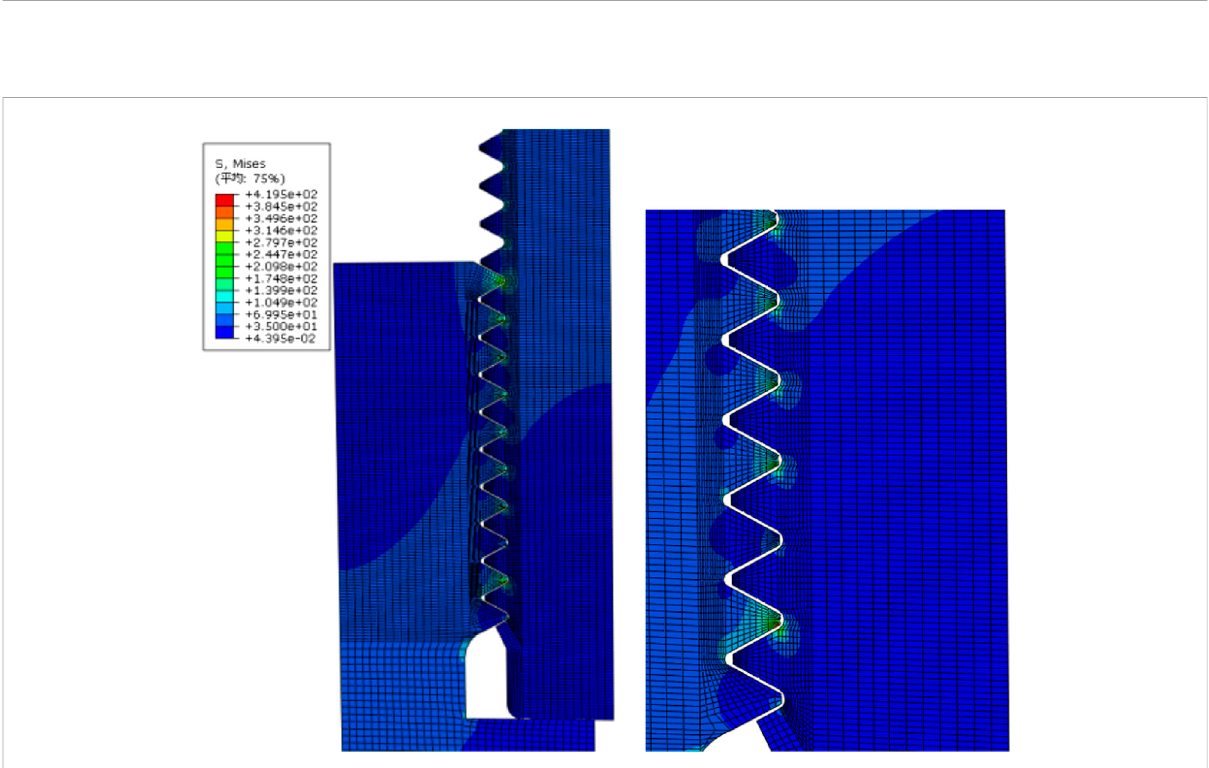
FIGURE 16 Equivalent force cloud on the contact surface of the thread.